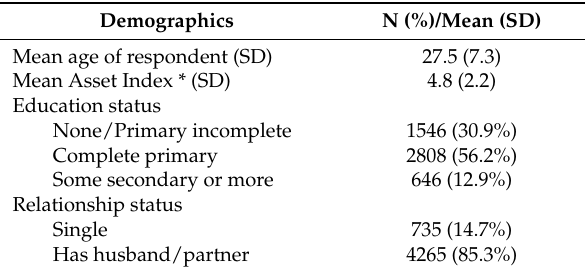
Table 1. Participant Demographics.